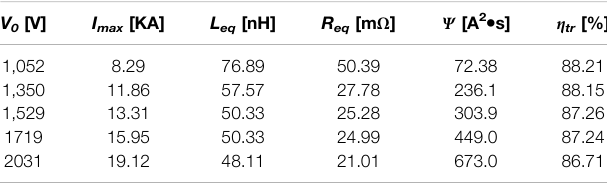
TABLE 1 | APPT discharge circuit parameter at different initial voltages.